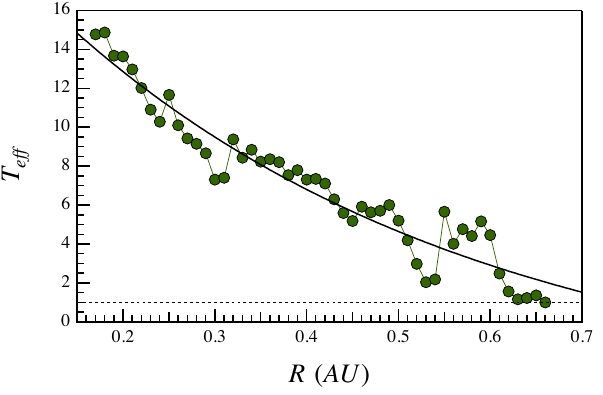
Figure 8. The effective temperature T ef f as a function of the radial distance R from the Sun. Solid line is an eye-guide. The horizontal dashed line refers to the critical value T ef f = 1.